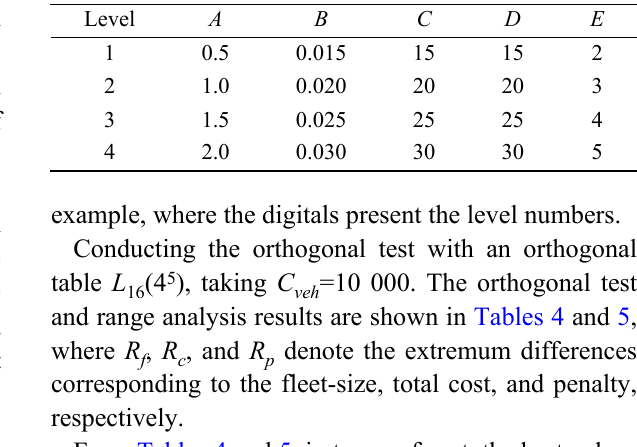
Table 3 Four levels for each of the five key